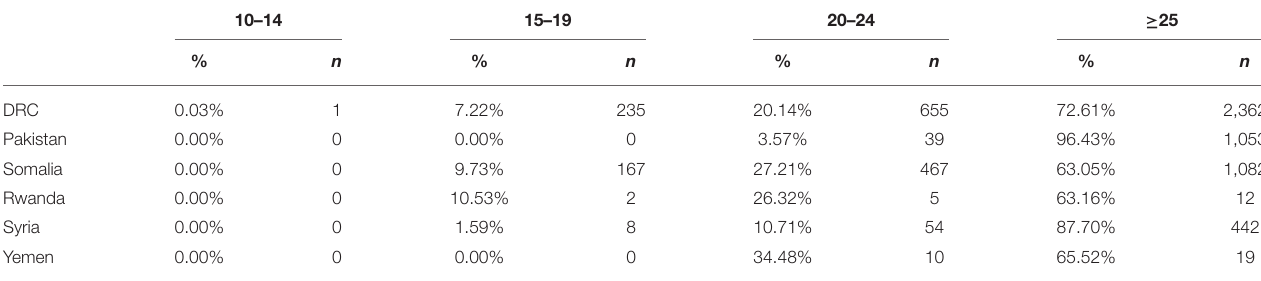
TABLE 2 | Age distribution of immediate postpartum LARC clients, by country